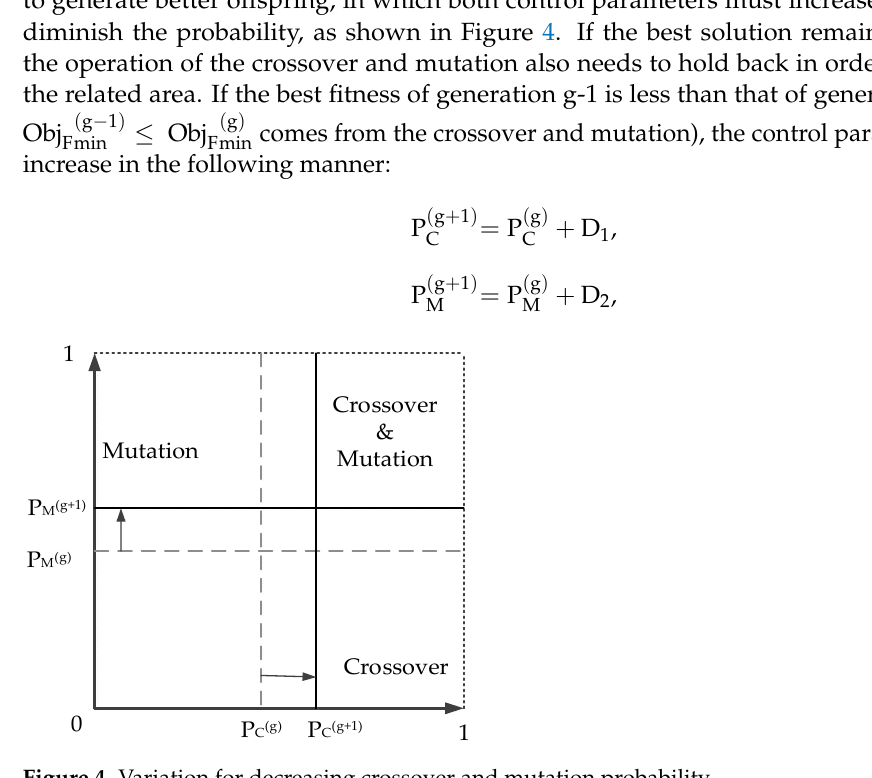
Figure 4. Variation for decreasing crossover and mutation probability.